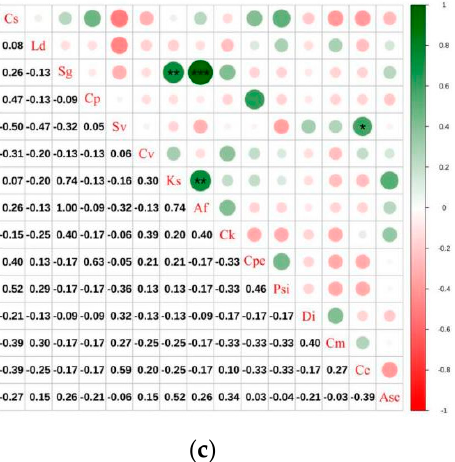
Figure 6. Semimatrix diagram of the Spearman rank association coefficient of different shrub-level sites. ( a ) Level I shrub grassland, ( b ) Level II shrub grassland, and ( c ) Level III shrub grassland. *, p < 0.05; **, p < 0.01; ***, p < 0.001. Aa: Anemarrhena asphodeloides ; Af: Artemisia frigida ; As: Artemisia